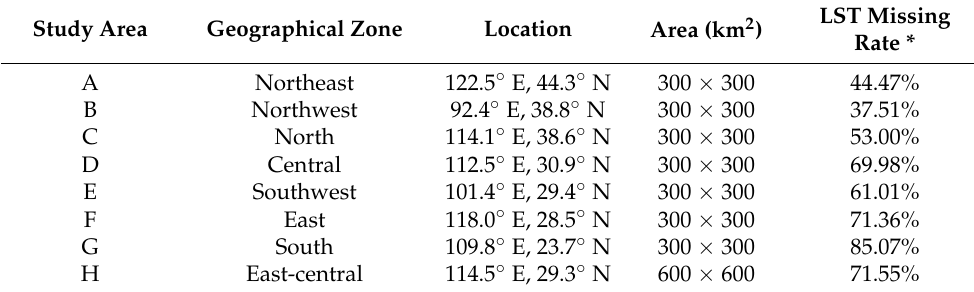
Table 1. Detailed information of the study areas.